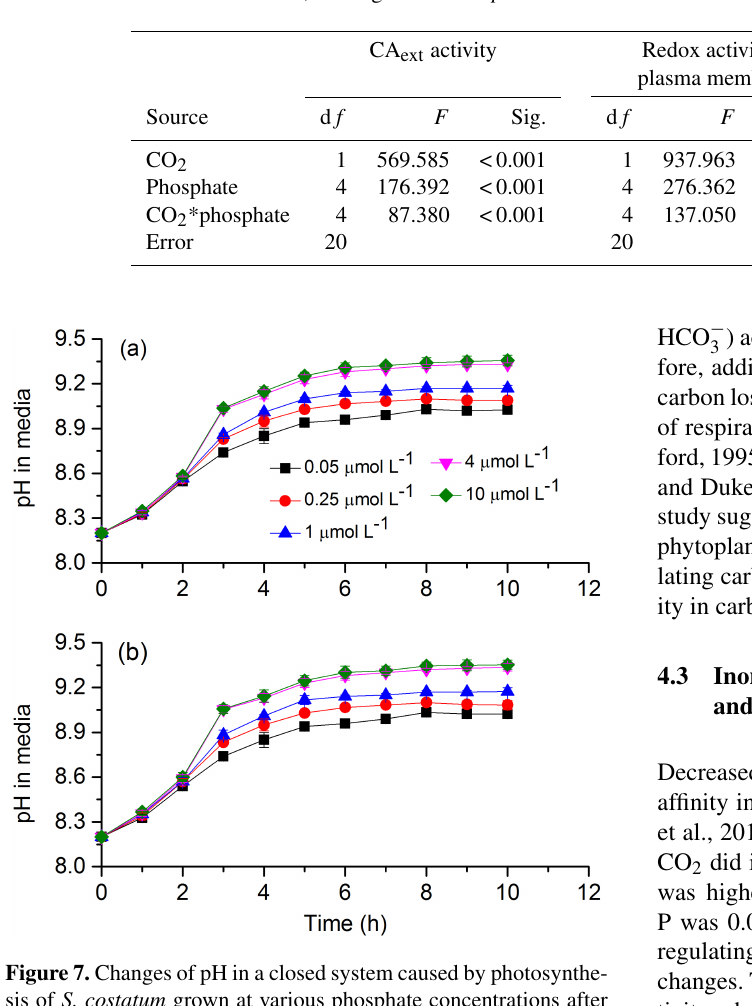
Table 3. Two-way analysis of variance for the effects of CO 2 and phosphate on CA ext activity, redox activity of plasma membrane, and pH compensation point of S. costatum . CO 2 *phosphate means the interactive effect of CO 2 and phosphate, d f means degree of freedom, F means the value of the F statistic, and Sig. means the p value.